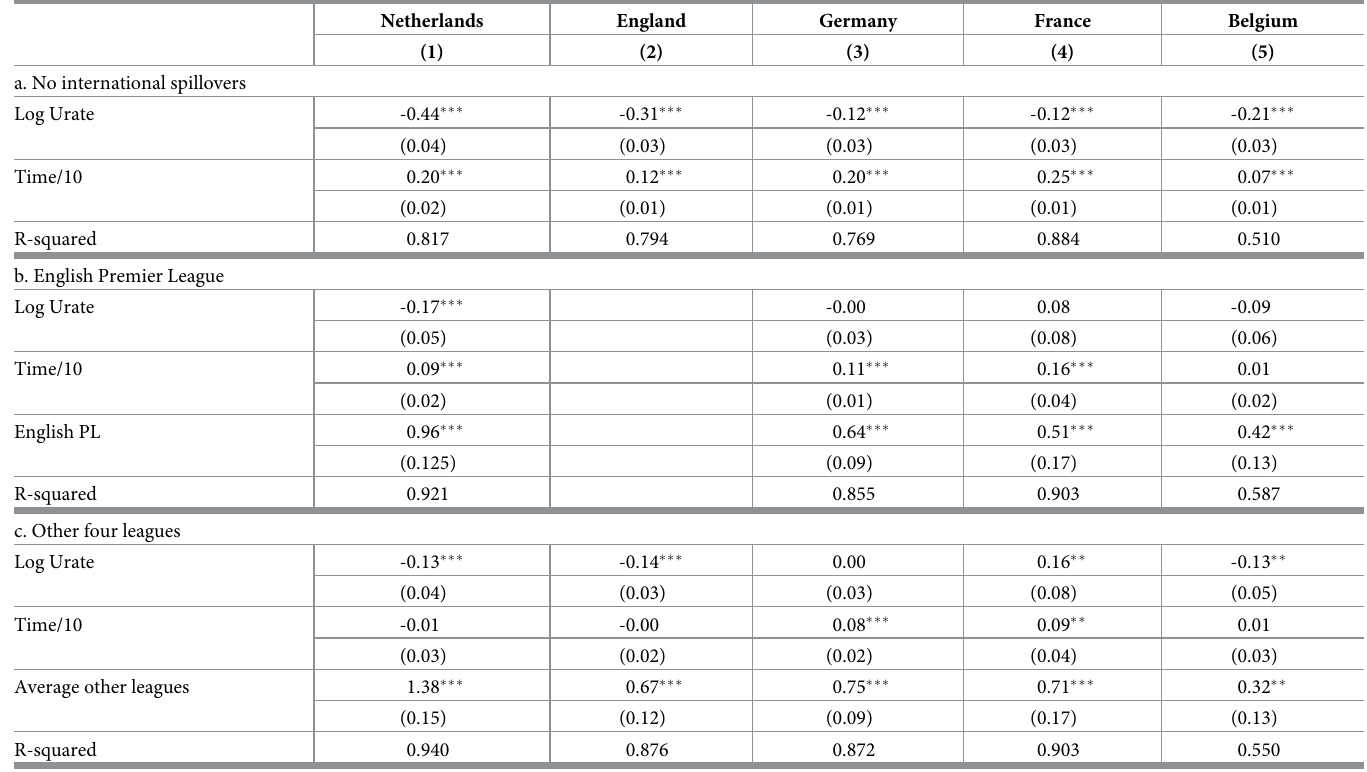
Table 6. Parameter estimates stadium attendance; average annual attendance top leagues;